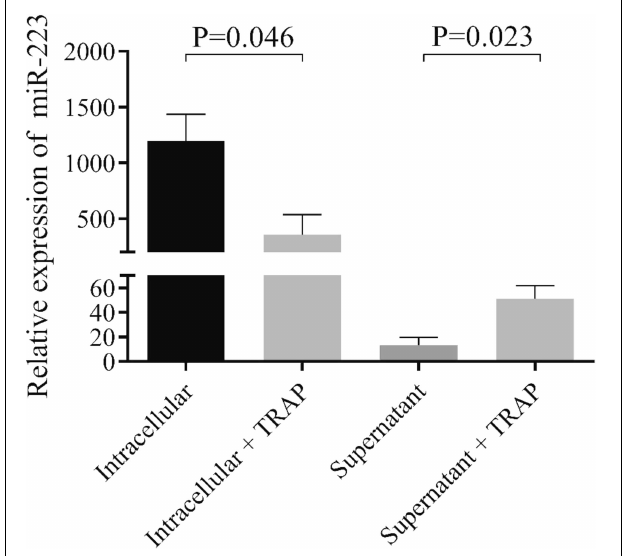
FIGURE 2 | Analysis of miR-223 in platelets and their supernatants before and after TRAP activation in vitro . Isolated platelets were stimulated with thrombin-receptor activating peptide (TRAP, 40 µ mol/L) for 2 h in non-stirring conditions. Platelets were then centrifuged, and platelet pellet and supernatant were processed for RNA extraction and miR-223 analysis. Platelets after stimulation (light gray column) showed decreased miR-223 levels compared to non-activated platelets (black column), while elevated miR-223 levels were detected in the supernatant with TRAP (gray column) ( n = 7–8 samples/experiment). Mann-Whitney U -test was performed for